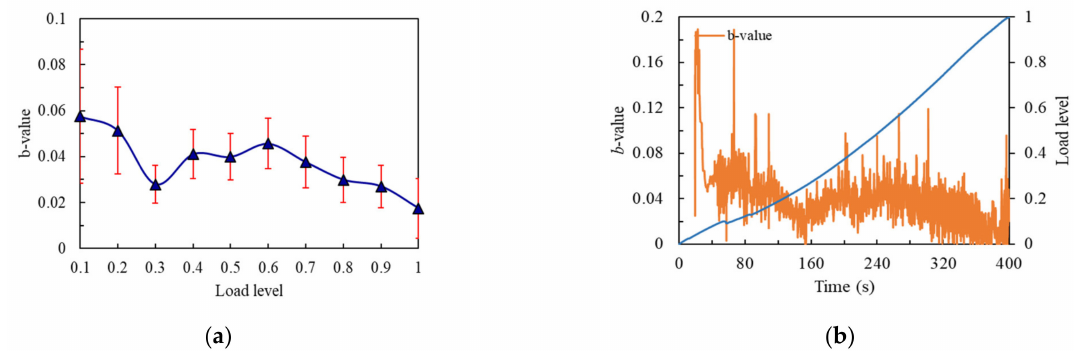
Figure 12. b -value curves of the No.6 notched beam: ( a ) b -value changes curve with load level; ( b ) b -value changes curve with